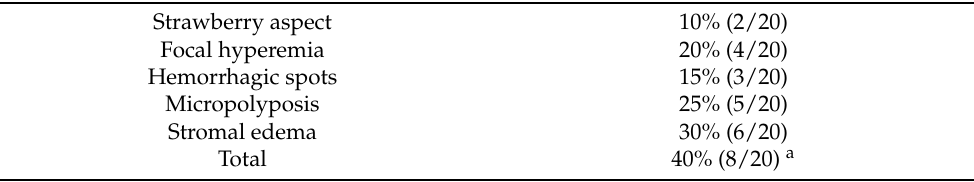
Table 1. The rate of hysteroscopic CE findings proposed by International Working Group for Stan- dardization of Chronic Endometritis Diagnosis [40] detected in patients with histopathologic CE. Strawberry aspect 10% (2/20) Focal hyperemia 20% (4/20) Hemorrhagic spots 15% (3/20) Micropolyposis 25% (5/20) Stromal edema 30% (6/20) Total 40% (8/20) a a Totals are not 100 percent due to some patients with multiple endoscopic